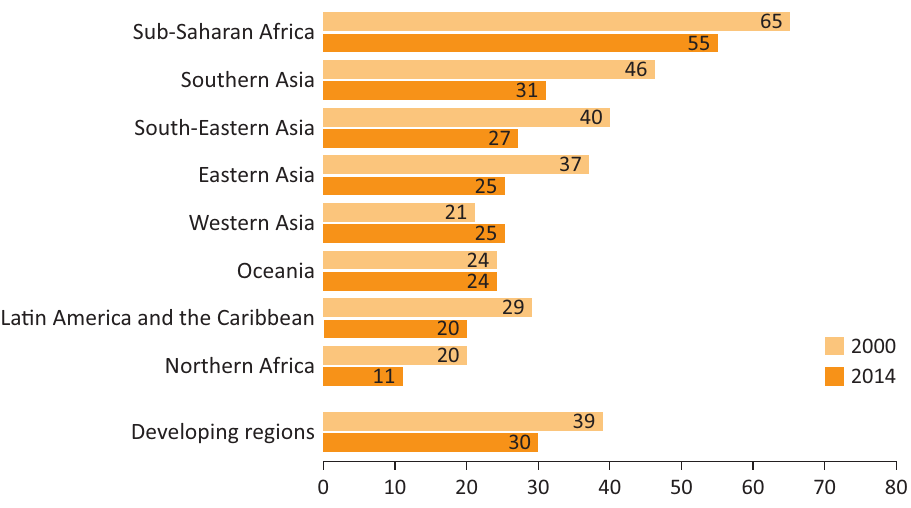
Figure 1. Proportion of urban population living in slums, in 2000 and 2014 (%). Source: UN-Habitat (2016). sumption. Slum regeneration suggests using more